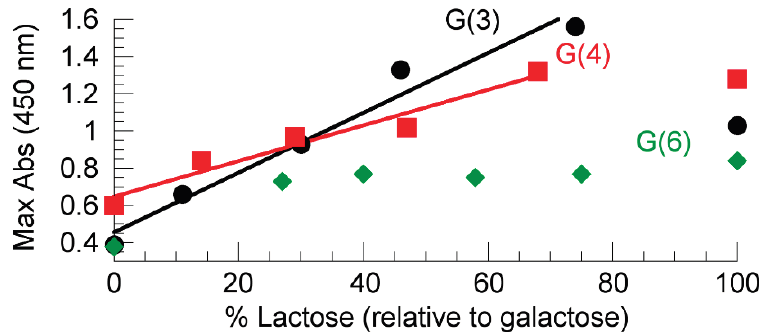
Figure 6. Percent lactose of the lactose/galactose functionalized dendrimers vs. maximum absorbance for binding of galectin-3 in a modified ELISA.